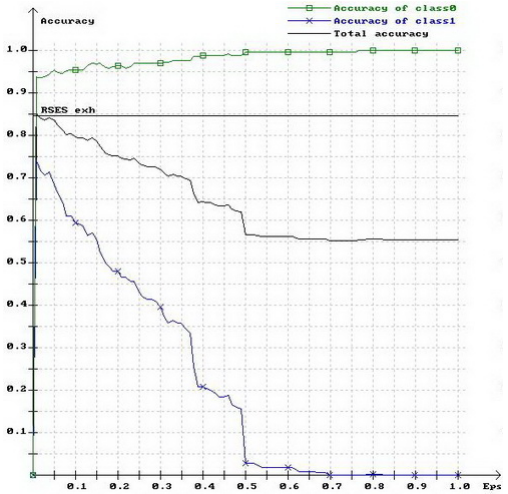
Fig. 8. Results for algorithm 6 v2, Best result for ε = 0 . 01: